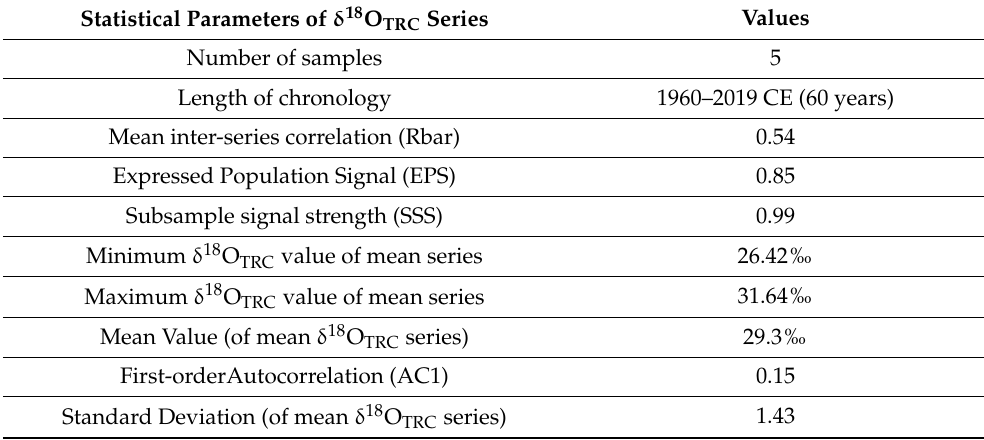
Table 1. Statistics of the mean tree-ring δ 18 O chronology of Abies spectabilis from Magguchatti, Kedarnath,